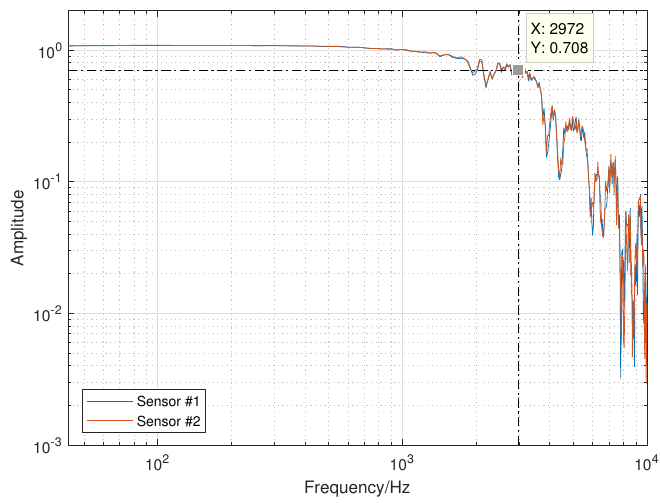
Figure 2. The transfer function between the LDV and the NSA signals for two